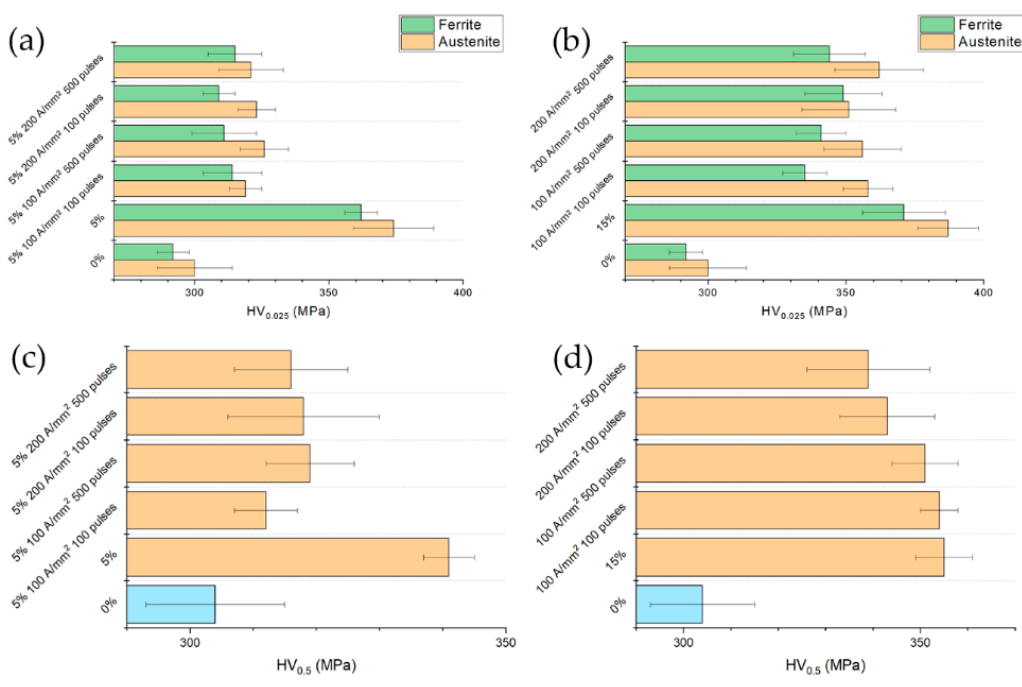
Figure 11. Single phase hardness and bulk hardness of specimens strained and electropulsed at ( a , c ) 5% and ( b , d ) 15% compared to the baseline (0%) and the related reference tests.